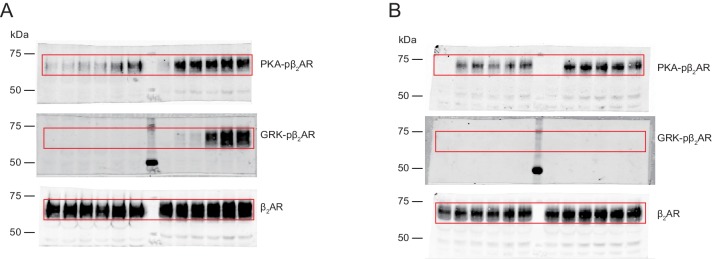
Uncropped blots for Figure 6C and D.(A) Uncropped blots corresponding to Figure 6C. (B) Uncropped blots corresponding to Figure 6D. Red box indicates the crop region displayed in main figure.